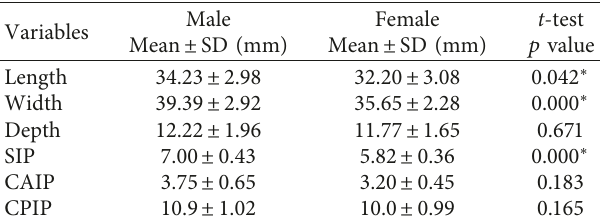
Table 3: Mean palatal arch dimensions, SIP, CAIP, and CPIP in Jordanian